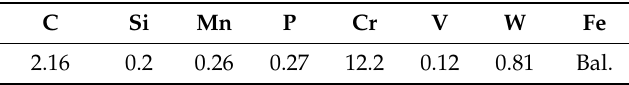
Table 1. Compositions of X210CrW12 steel specimen